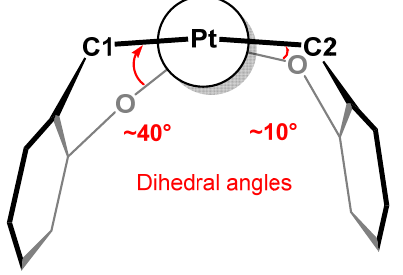
Figure 6. Schematic view along the Pt—P bond of the conformations adopted by the two cyclomet- alated 6-membered rings together with the values of the O-P-Pt-C dihedral angles. The carbonyl complex 3 · CO was selectively obtained by exposing dichloromethane solutions of the parent dimethylsulfide adduct to 1 atm of CO (Scheme 3). The unexpect- edly high value of 2140 cm − 1 found for the C ≡ O stretching vibration in the IR spectrum of